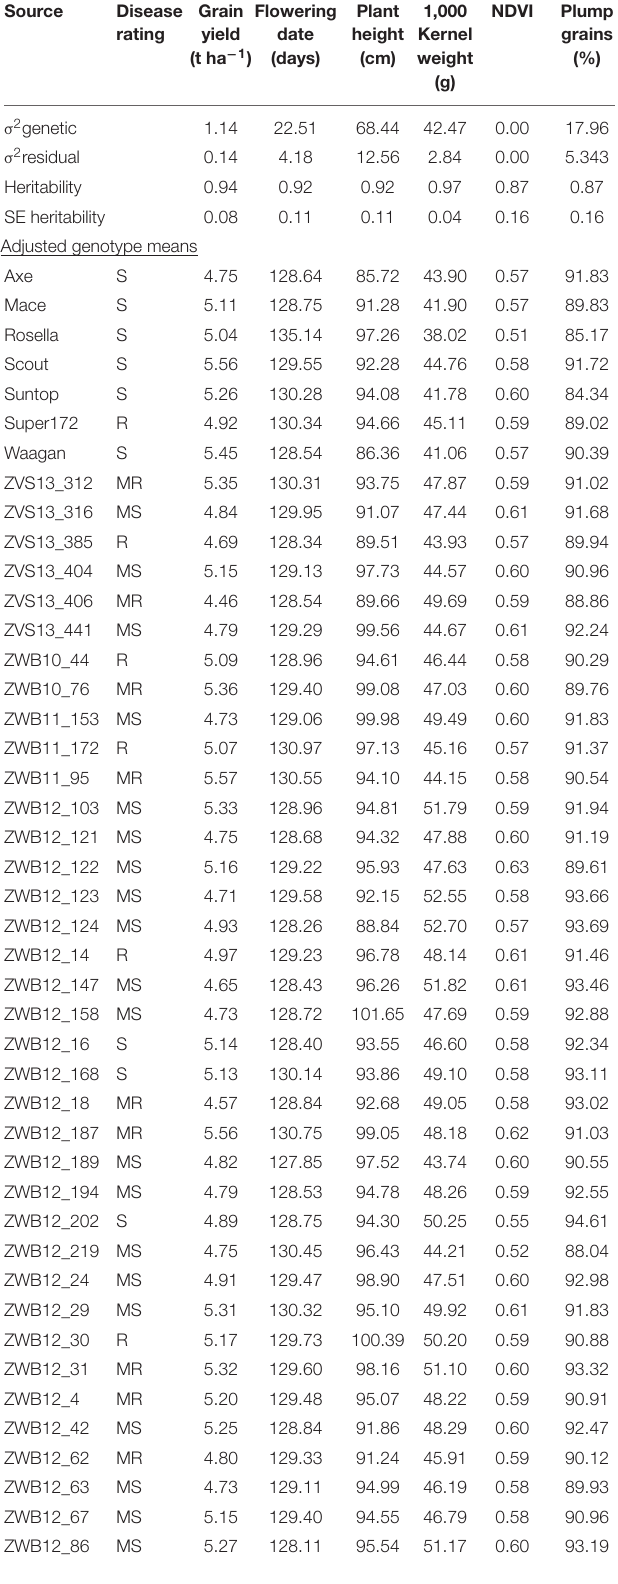
TABLE 2 | Spatially adjusted means of check varieties and CIMMYT-derived, Karnal bunt resistant germplasm. Source Disease Grain rating